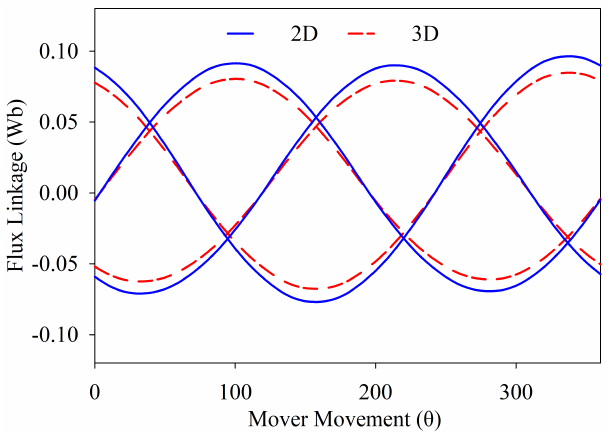
Figure 18. Flux linkage of 3D and 2D single-sided VFPMLM.